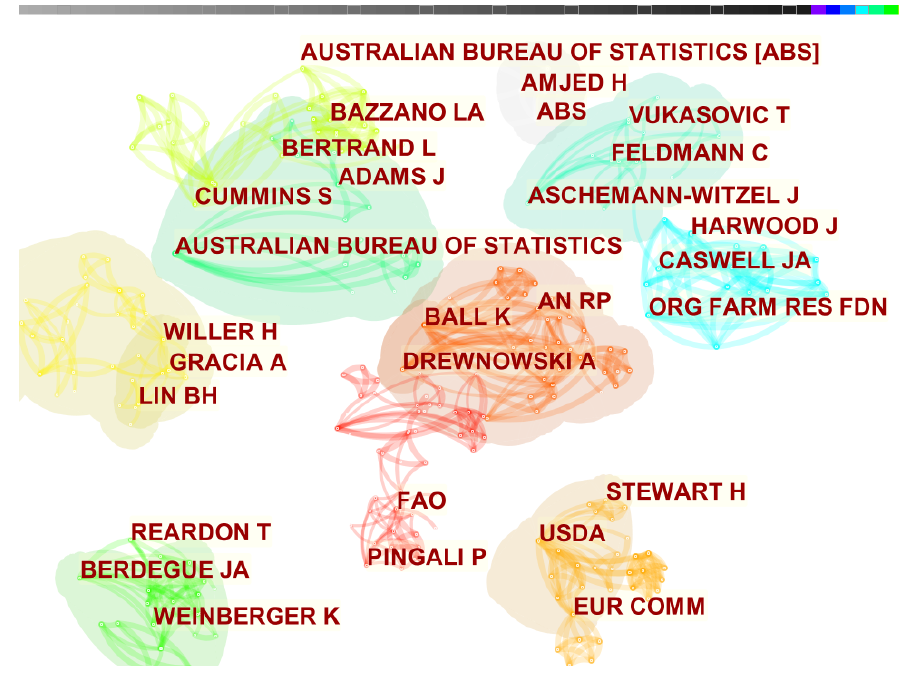
Figure 8. WOS Co-citation Analysis Diagram. Table 5. Ranking of WOS Co-occurrence